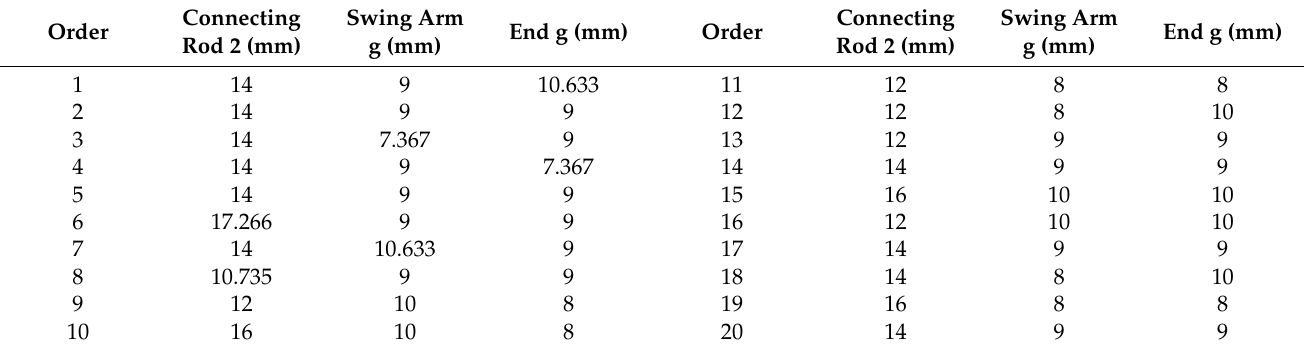
Table 3. Center composite design experimental data design table of bar thickness.